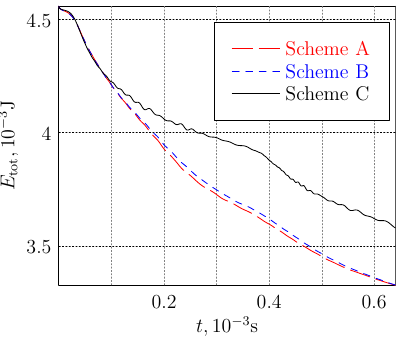
Figure 3. Problem 3.1: plots of E kin ( t ) 10 − 5 J m 2 / kg. for the schemes for λ 1 = 2 · ·